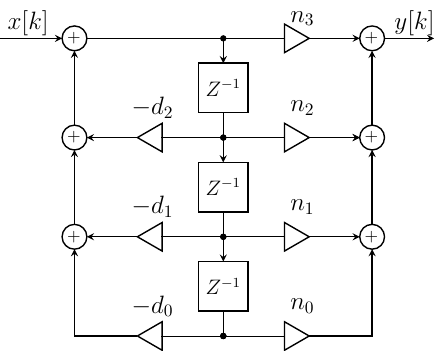
Figure 15. Normal Direct Form-II realization of the discrete transfer function of Equation